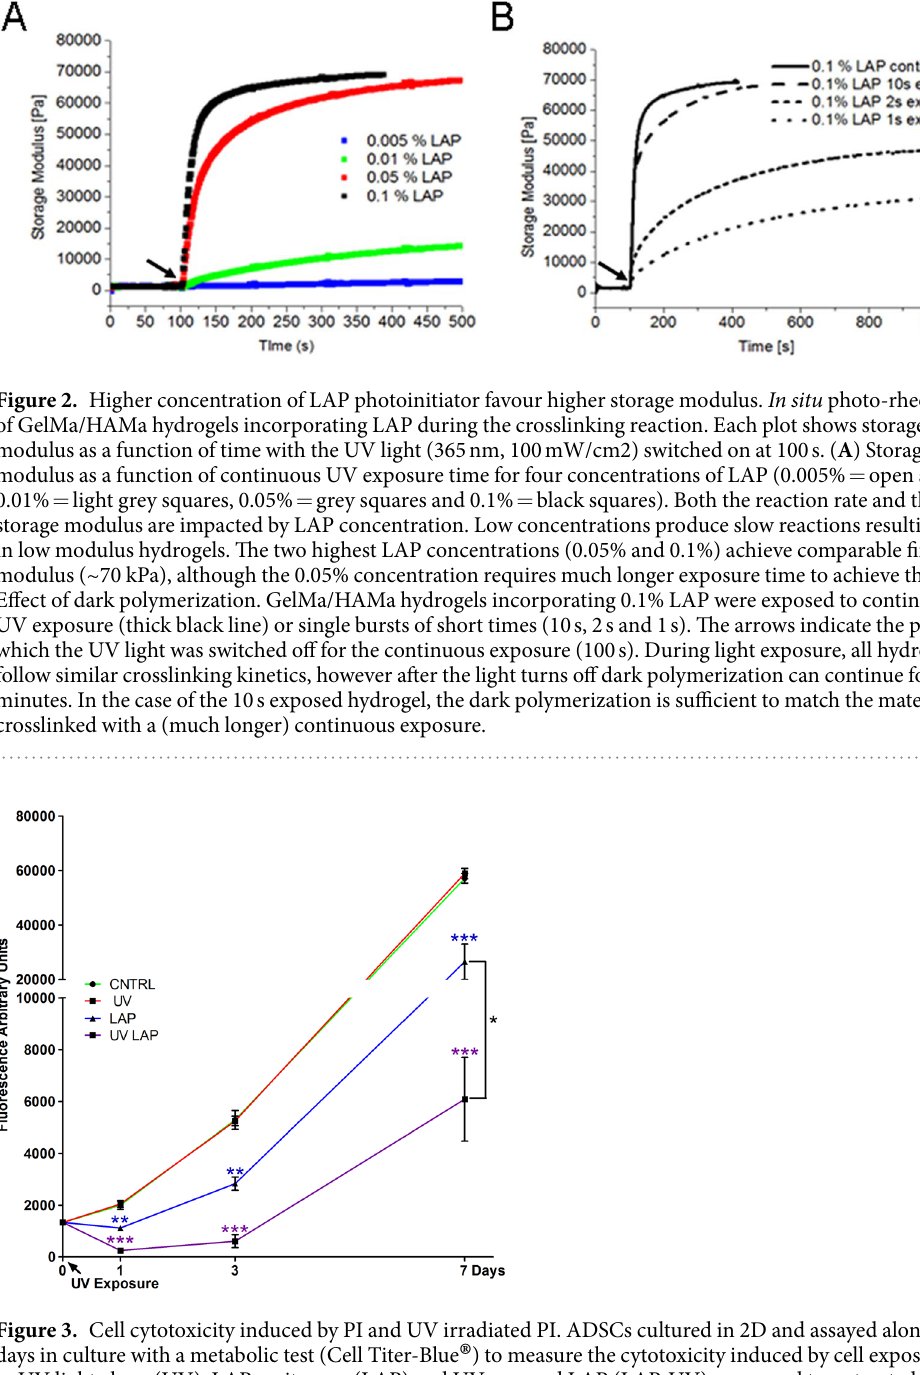
not reduced by exposing the cells to lower concentrations of LAP.